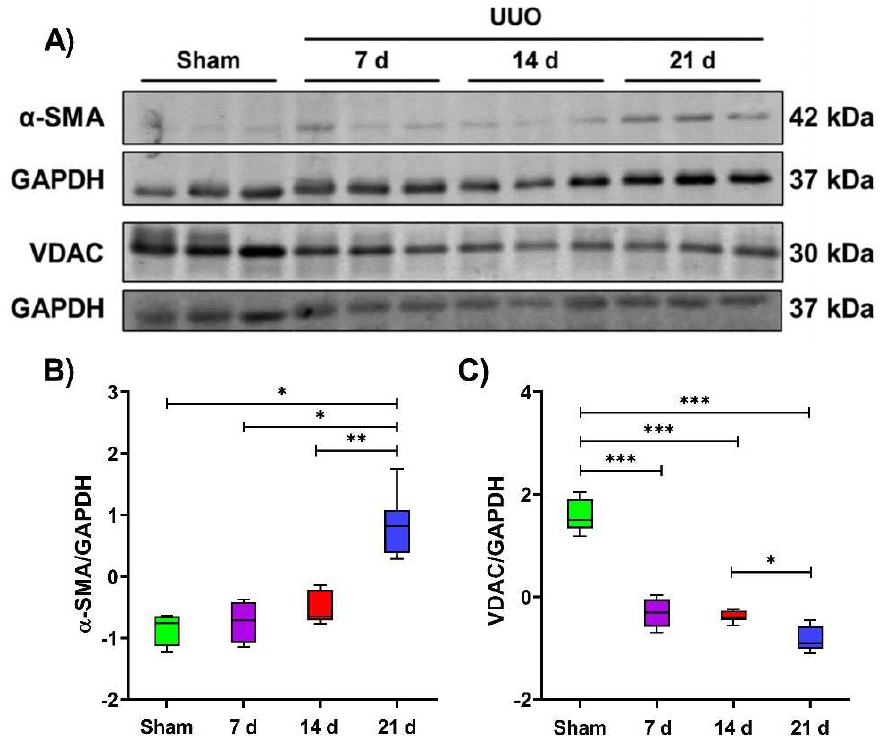
Figure 1. Mitochondrial VDAC alterations during the temporal course of unilateral ureteral obstruc- tion (UUO). ( A ) Representative blots of the fibrotic marker alpha–smooth muscle actin ( α –SMA) and the mitochondrial constitutive protein voltage–dependent anionic channel (VDAC) levels during 7, 14, and 21 days after UUO; glyceraldehyde 3–phosphate dehydrogenase (GAPDH) was used as a loading control. All Western blot measurements were performed in whole tissue lysate. ( B , C ) sta- tistical analysis of the levels of α –SMA and VDAC. Data are represented as mean ± SD of two technical replicates from three rats per group; each technical replicate was standardized to Z( µ = 0, σ ). * p < 0.05, ** p < 0.01, *** p <